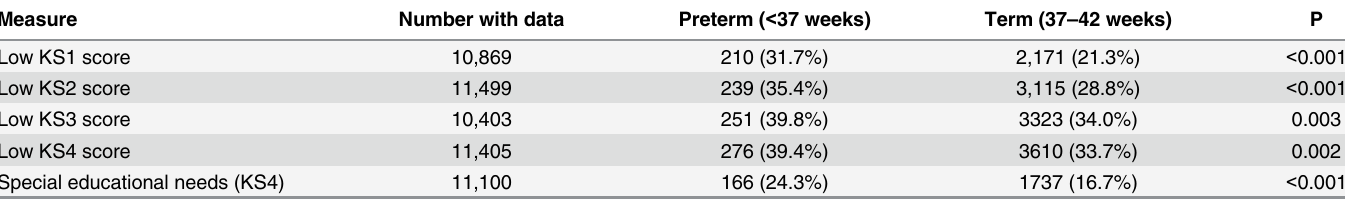
Table 2. Educational Measures, and Special Educational Needs, split by gestation.